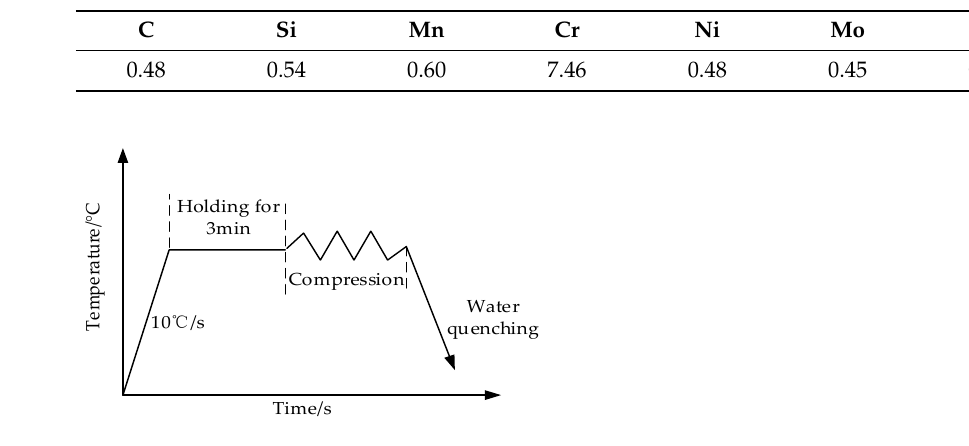
Table 1. Chemical element compositions of Cr8 steel, wt%.